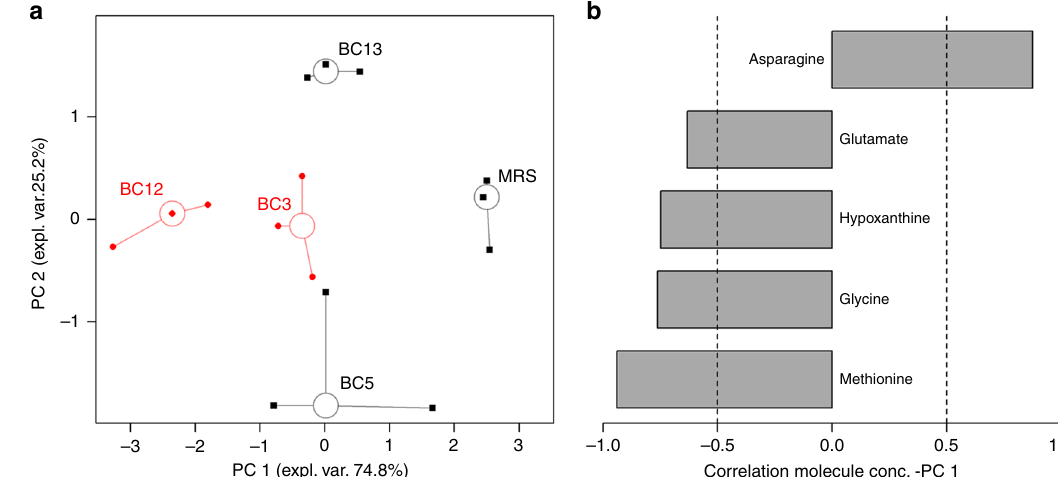
Fig. 8 Principal component analysis of metabolomes in Lactobacillus- derived EVs. a rPCA model calculated on the space constituted by the concentration of the molecules signi fi cantly related to antiviral activity against HIV-1. Empty circles highlight the median values of the repetitions for each sample, while black and red colors highlight samples with low and high anti-HIV-1 activity, respectively. b Bar plot describing the correlation between the concentration of each molecule and its importance along PC